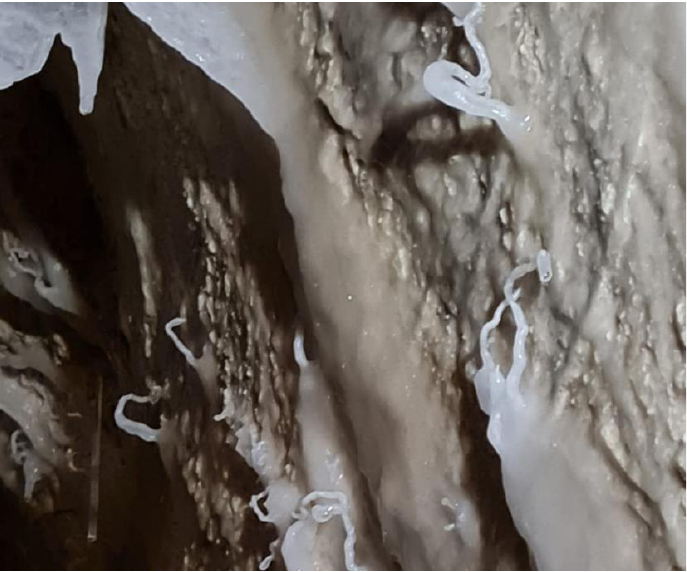
Figure 6. The eccentric stalactites in “Sala dell’Infinito”. As it is possible to see, they are growing upwards.